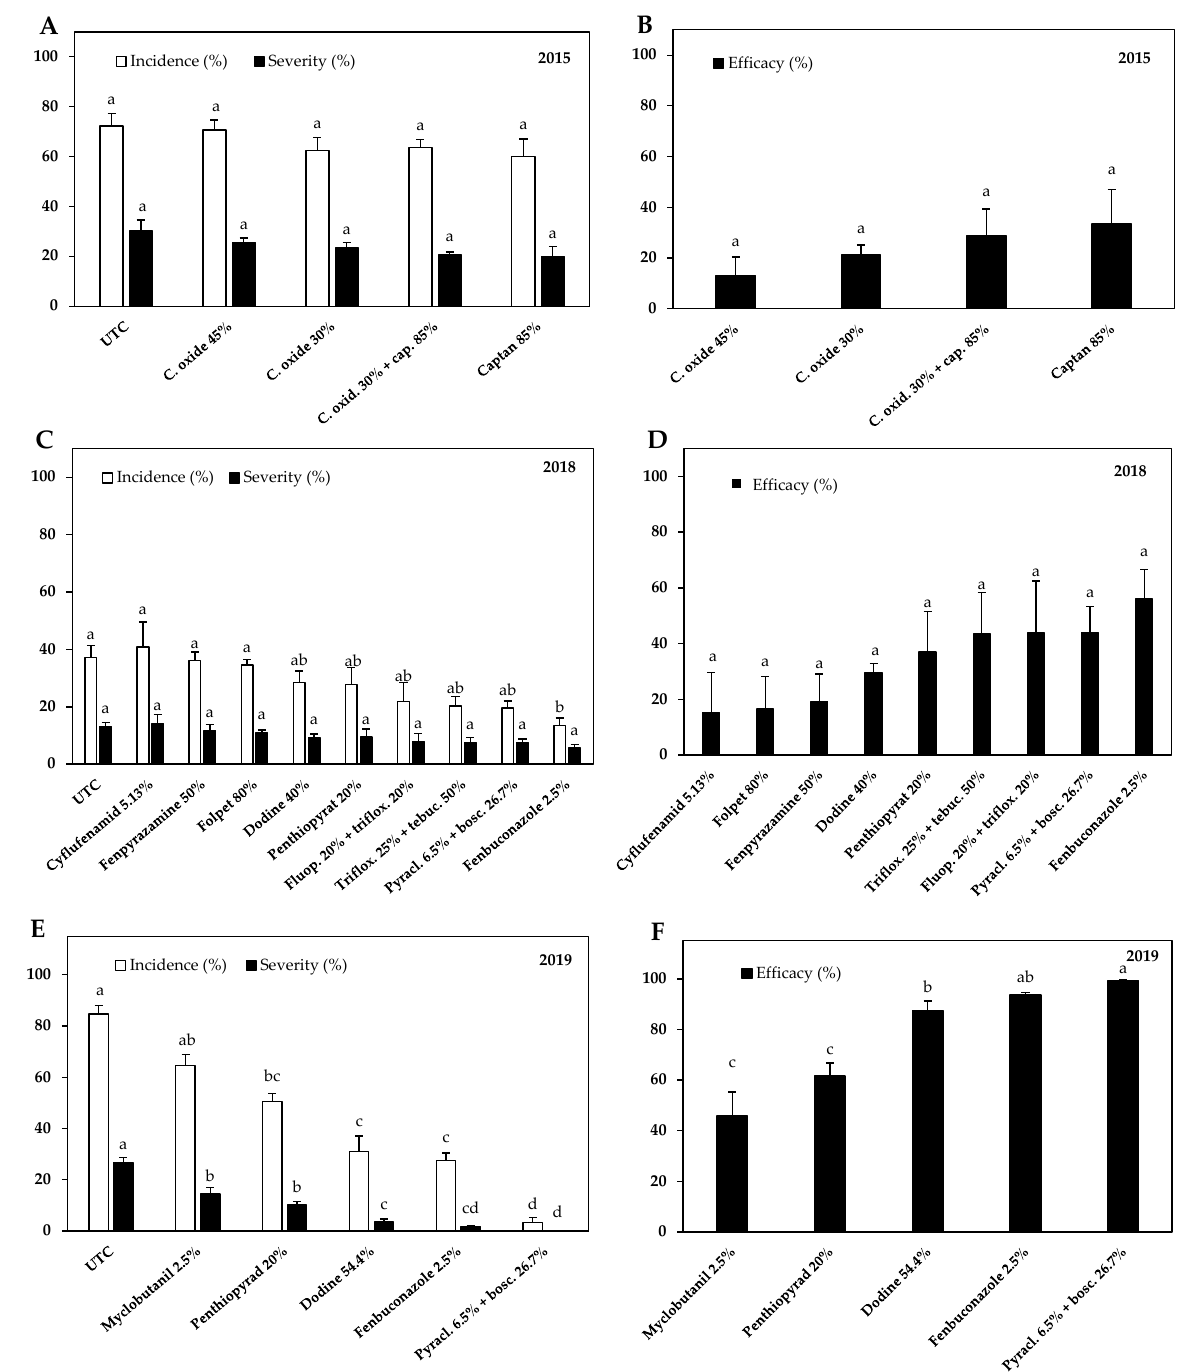
Figure 2. Disease incidence and severity ( A , C , E ) and control efficacy ( B , C , F ) of red leaf blotch in almond trees managed with different contact and systemic fungicides in non-alternating sprays (2015, 2018, and 2019). The efficacy was calculated using Abbott’s formula [29]. Treatment means with different letters are significantly different according to Tukey–Kramer’s test ( p < 0.05). The error bars indicate the standard error of the mean.